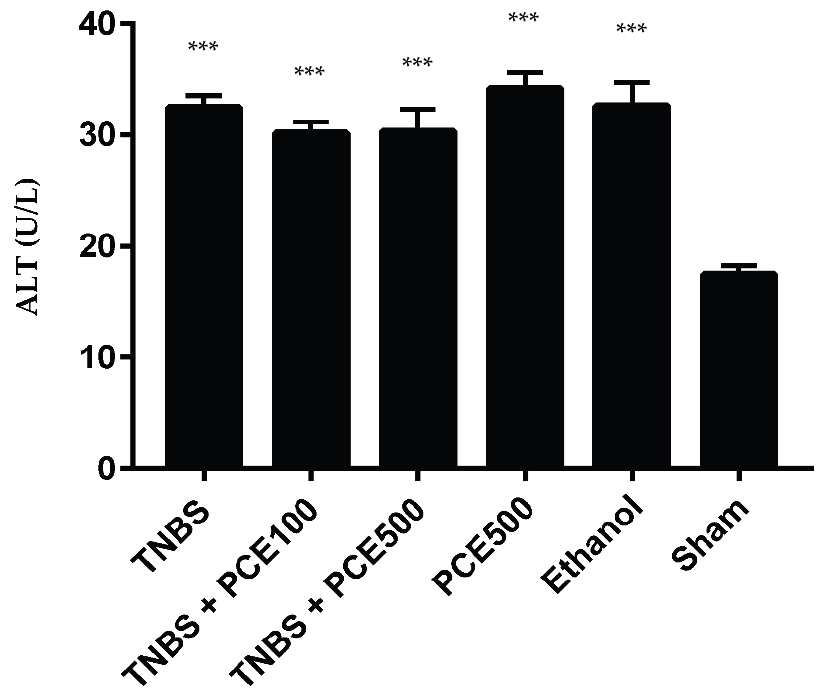
Figure 7. Effect of PCE treatment on ALT concentration in the IBD. The results are represented as mean ± SD [ n (TNBS + PCE100) = 10; n (TNBS + PCE500) = 10; n (PCE) = 10; n (TNBS) = 6; n (Ethanol) = 5; n (Sham) = 5; *** p < 0.001compared with sham group, one-way ANOVA followed by Tukey’s